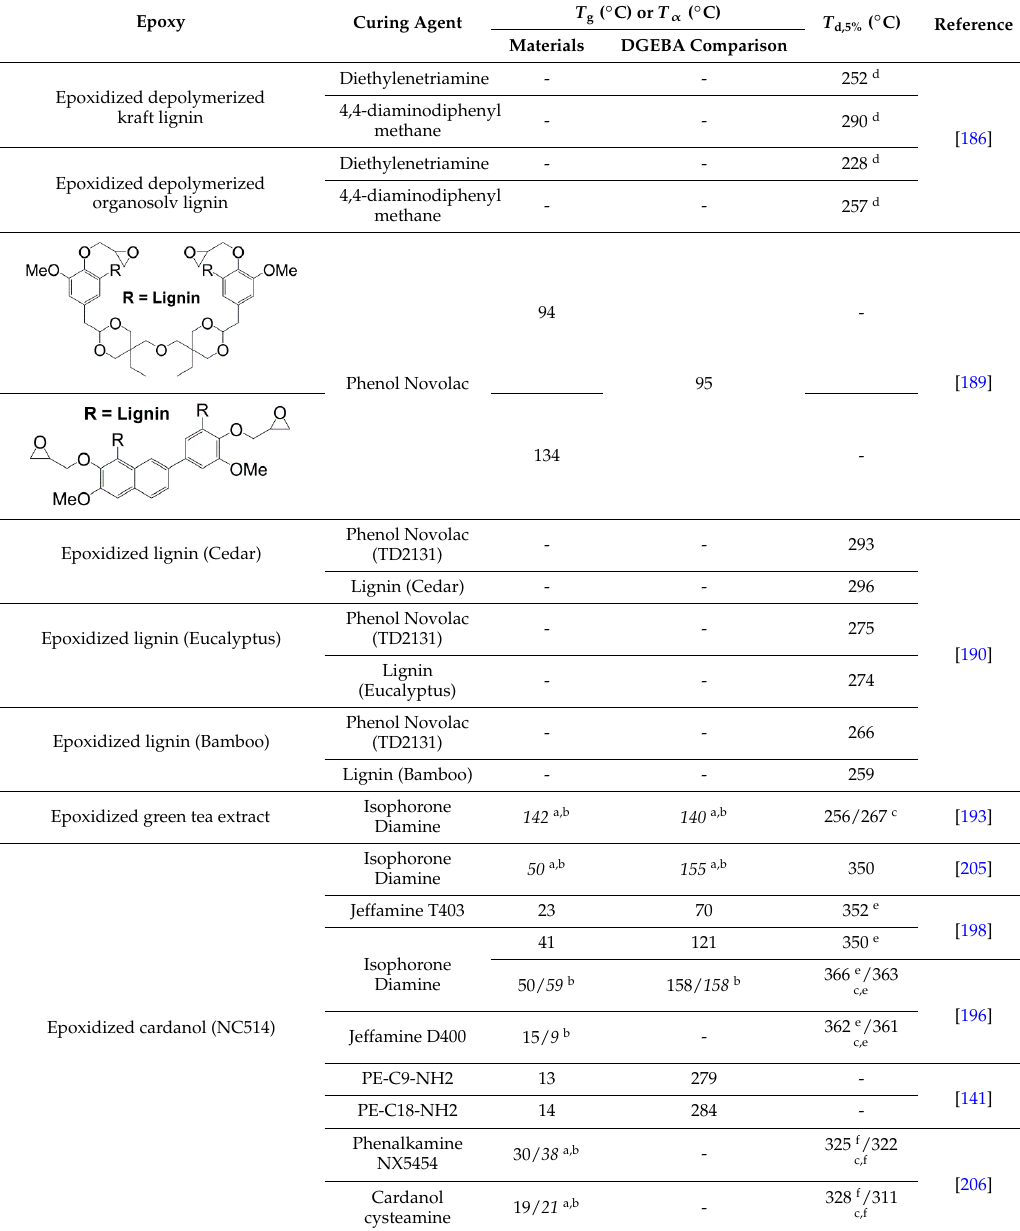
Epoxy Curing Table 6. Poly-aromatic epoxy monomers from crude bio-mass and thermal properties of the Epoxy cured materials.